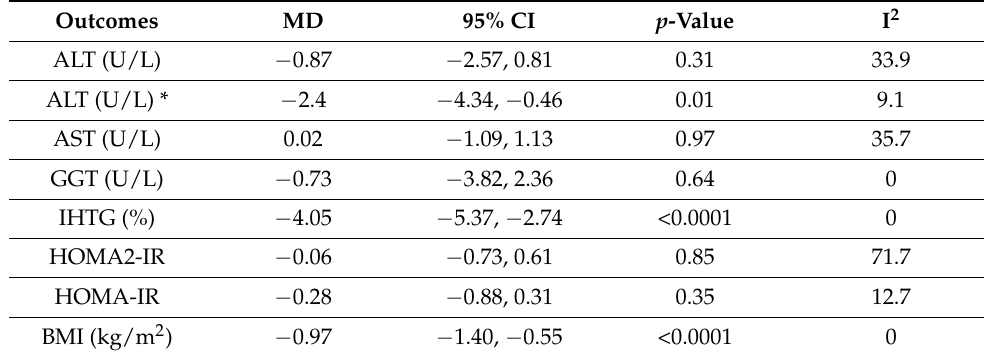
Table 4. Pooled effect sizes based on aerobic exercise intervention in treating MAFLD.